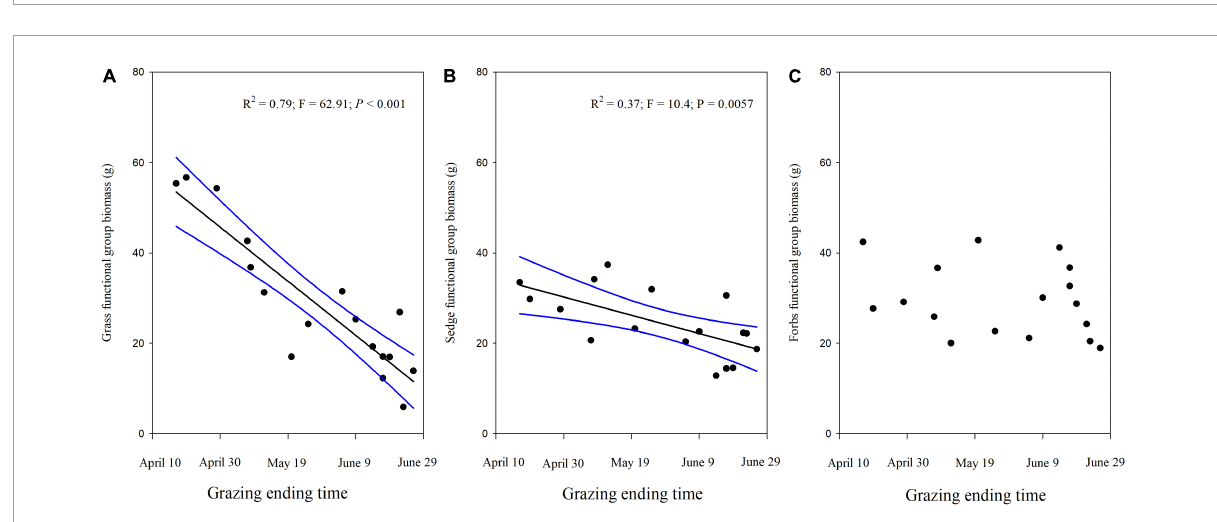
FIGURE3 Biomass of the three functional groups (A) Grass biomass. (B) Sedge biomass. (C) Forbs biomass for different grazing termination times on winter pastures in alpine meadows based on a linear regression. The black lines indicate significant regression relationships and blue lines indicate the smoothed regressions with its 95% confidence